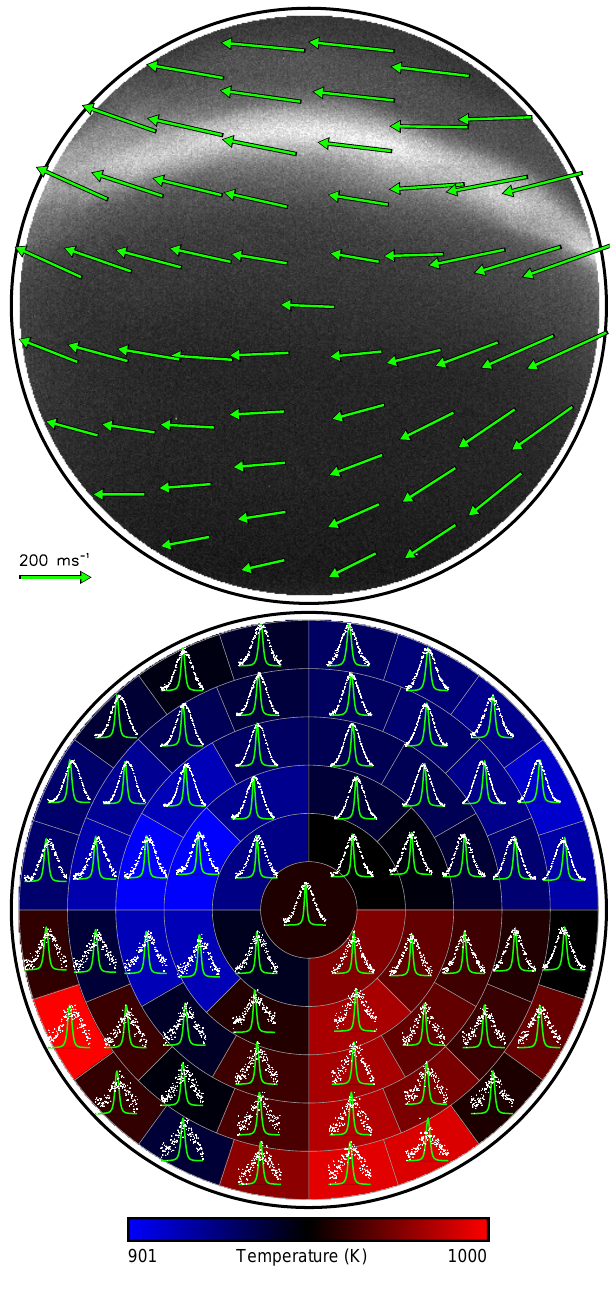
Fig. 2. Top: Fitted wind vectors (offset-corrected) superimposed over the corresponding all-sky image. Bottom: Zone map show- ing recorded spectra (white) and instrument profiles (green) for the same exposure. The temperatures estimated from these sky profiles are shown as blue/red hues (with the range indicated by the scale bar below the figure). This data was recorded on 23 May 2007, at 17:07 local solar time, with an exposure time of 150s. Magnetic north is at the top of these images, east is to the